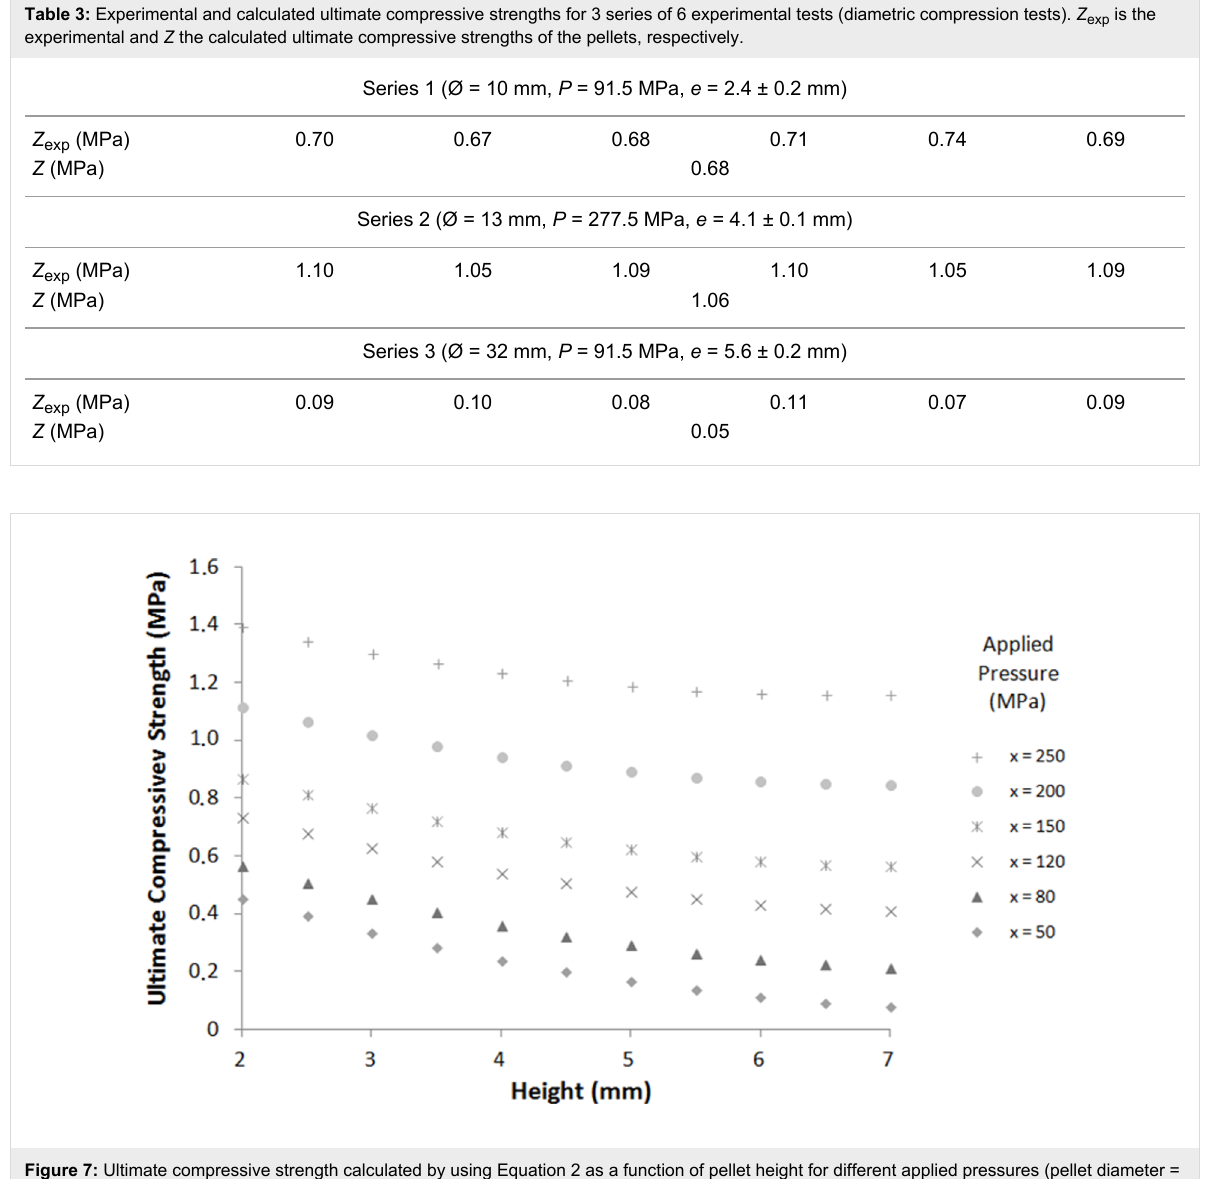
Figure 7: Ultimate compressive strength calculated by using Equation 2 as a function of pellet height for different applied pressures (pellet diameter = 10